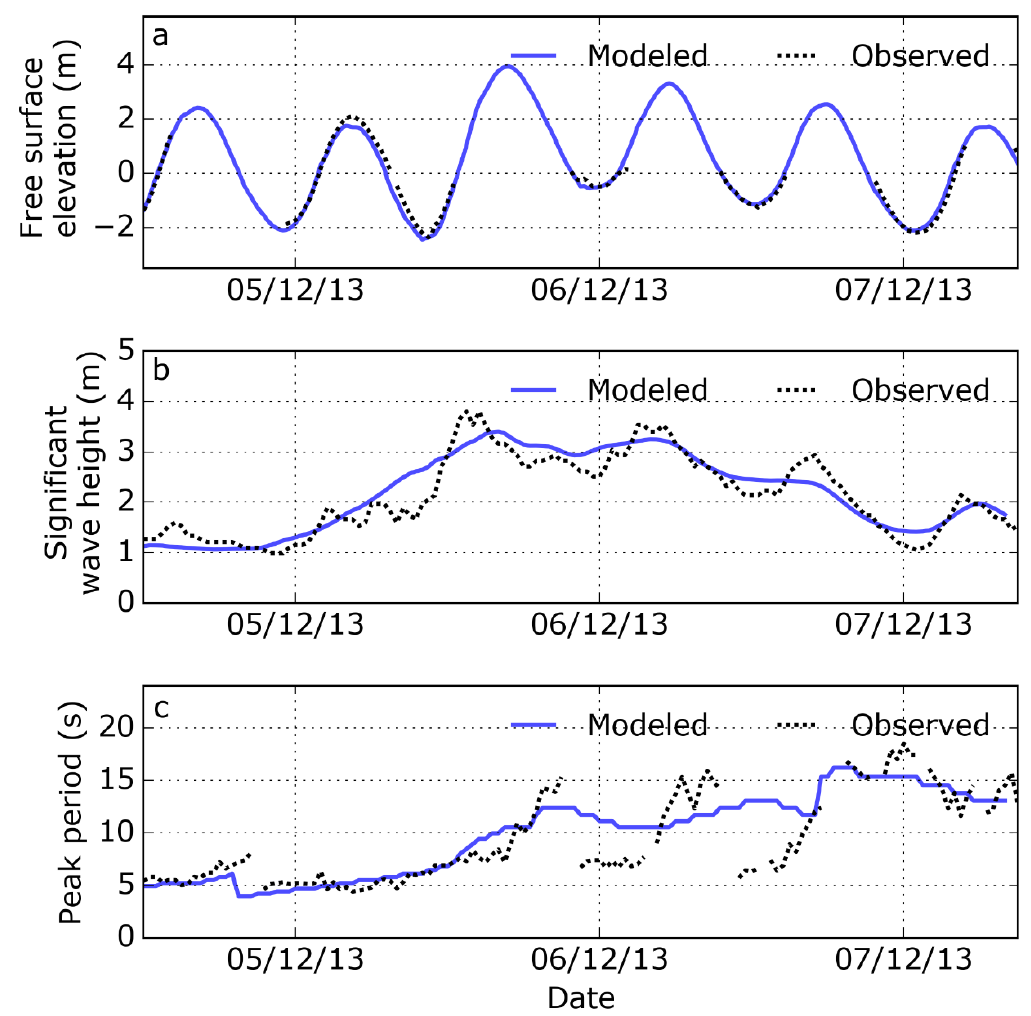
Figure 6. Comparison of modeled and observed water levels and wave characteristics for the period 4 December 2013 15:00:00 to 7 December 2013 12:00:00: ( a ) significant water levels at Cromer; ( b ) significant wave height at Blakeney Overfalls; ( c ) peak period at Blakeney Overfalls. RMSE = 0.23 m for water levels, 0.30 m for significant wave height, and 2.5 s for wave period. For locations, see Figure 1b.